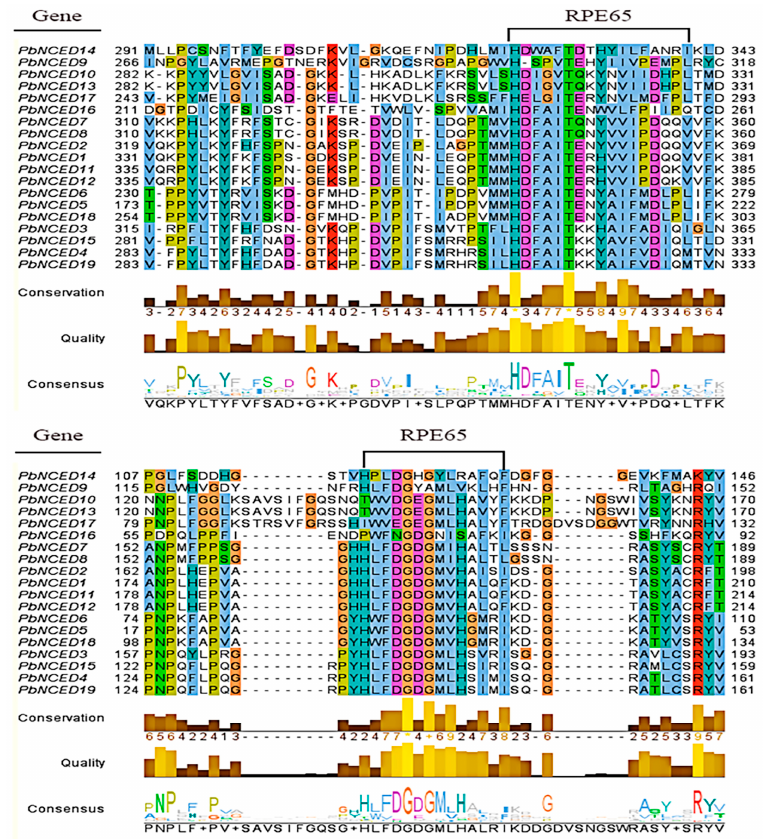
Figure 2. The RPE65 domain of PbNCED gene family protein.